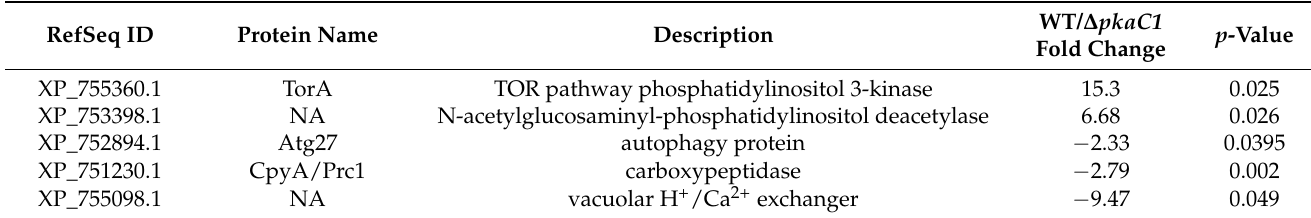
Table 1. Likely autophagy-associated proteins exhibiting PKA-dependent expression.